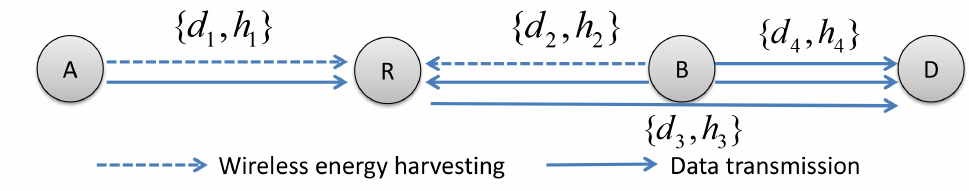
Figure 1. Wireless powered relay system with uplink